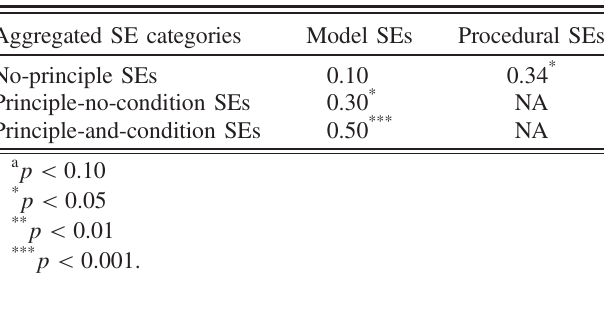
(Procedure: Principle-and-condition-SEs and Procedure: Principle-no-condition SEs) were nearly nonexistent and, therefore, correlations would be meaningless.